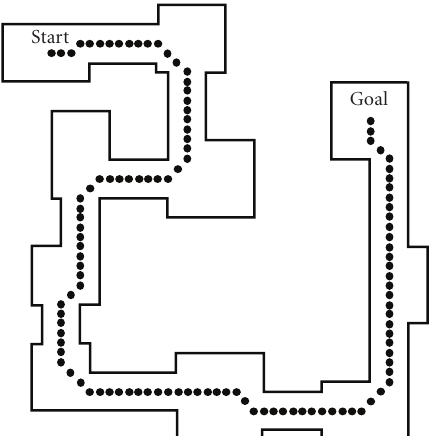
Figure 2: Aesthetic pathfinding with beautifying treatment for trial